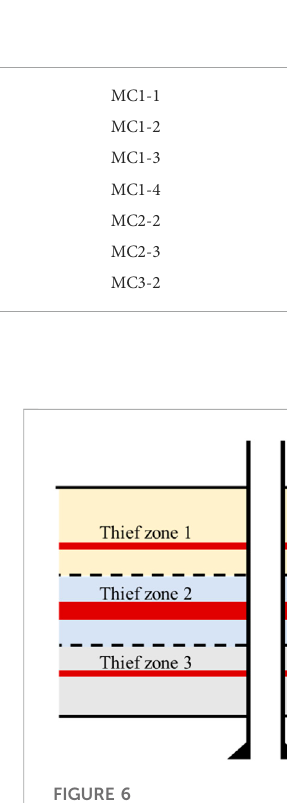
TABLE 1 Lower limit values of the thief-zone permeability of 14 members in the Mishrif Formation (except the four interlayers). Member